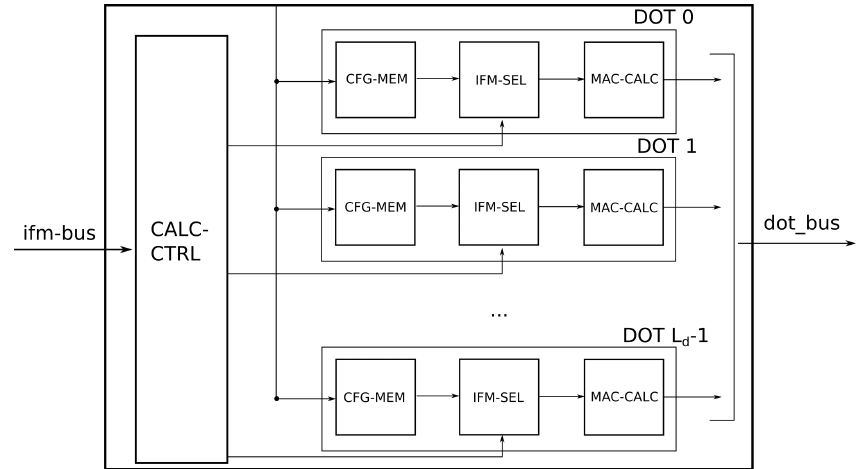
Figure 3. CALC architecture.